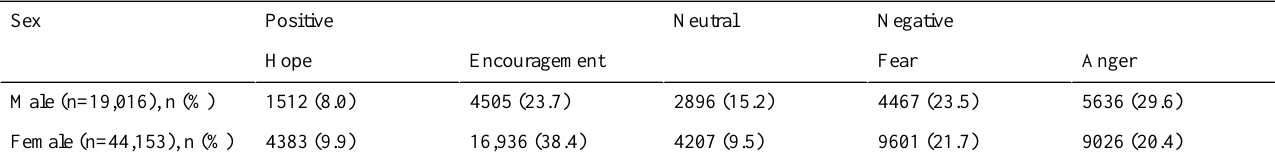
Table 4. Proportion of users’emotional polarities across different genders (N=63,169).